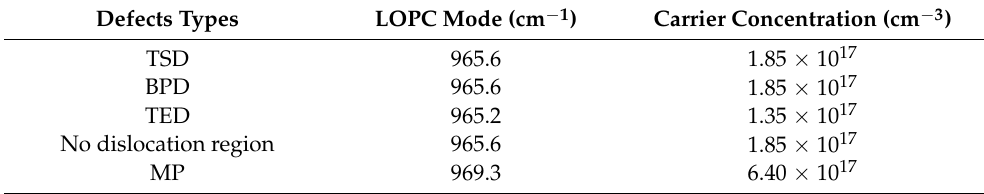
Table 2. LOPC modes and carrier concentrations of different dislocations in